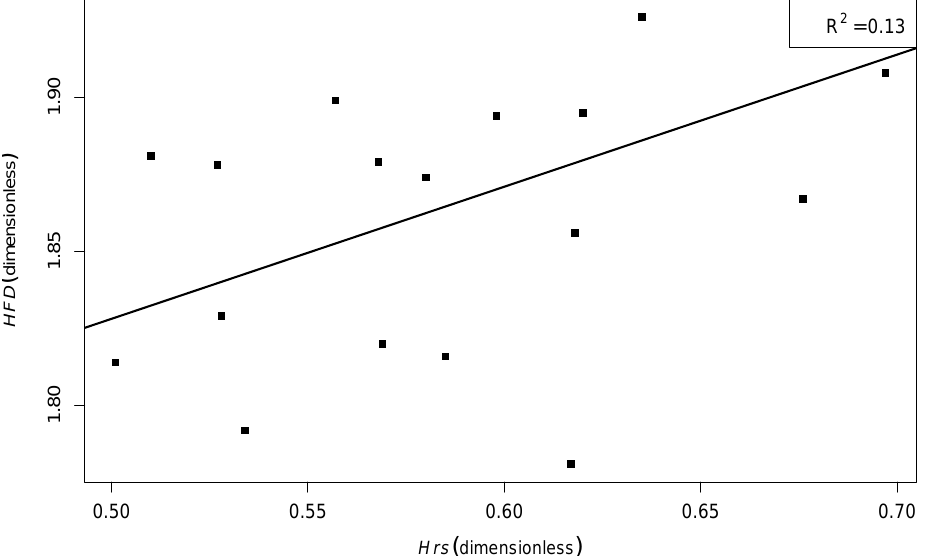
Figure 6. Relation between fractal exponents, showing the coefficients of determination (R 2 ) of the